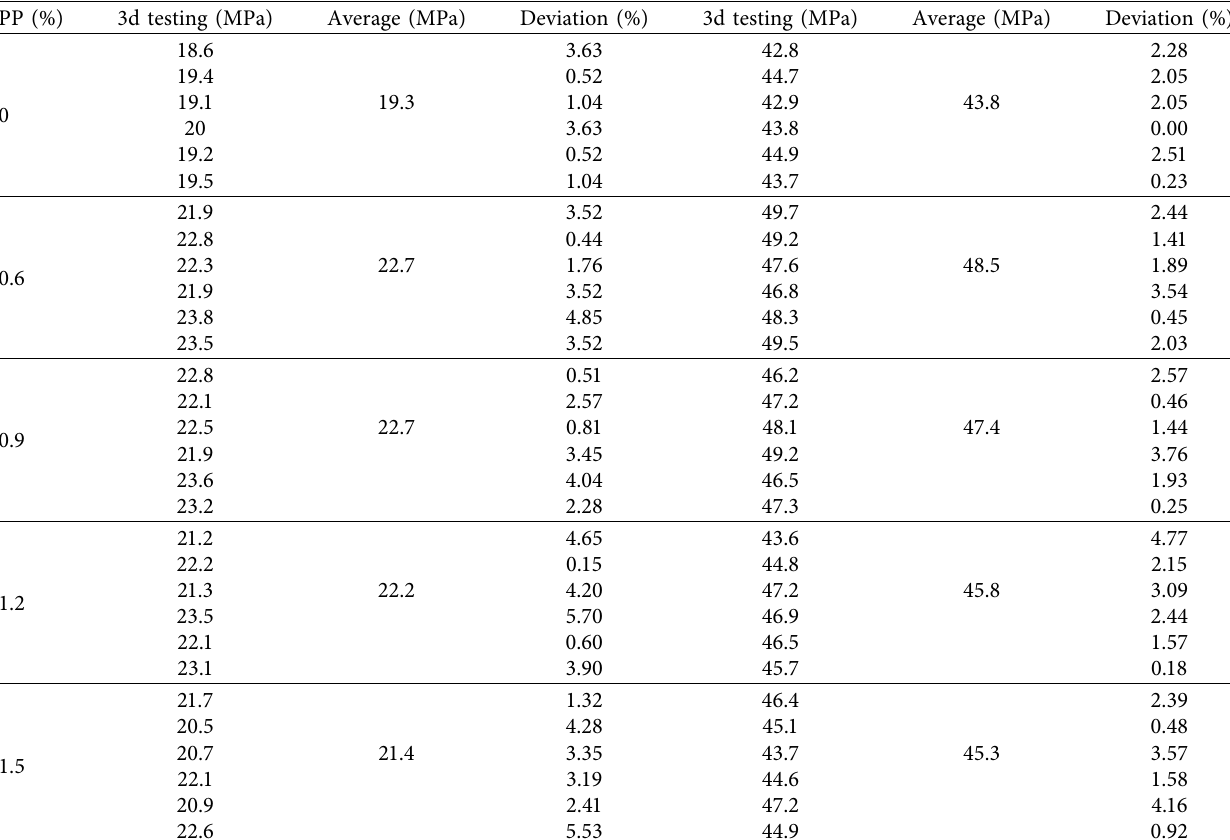
Table 5: Testing results of compressive strengths and their deviations.